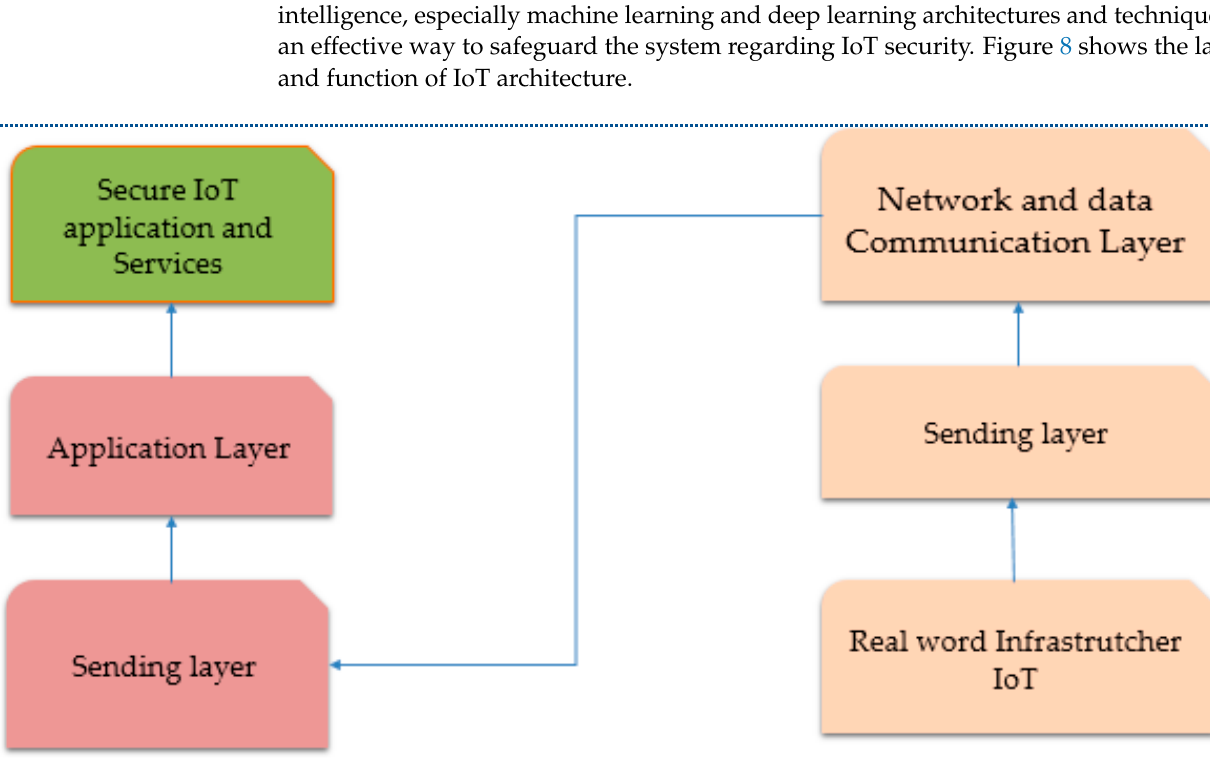
Figure 9. A machine learning security framework for IoT systems [96].